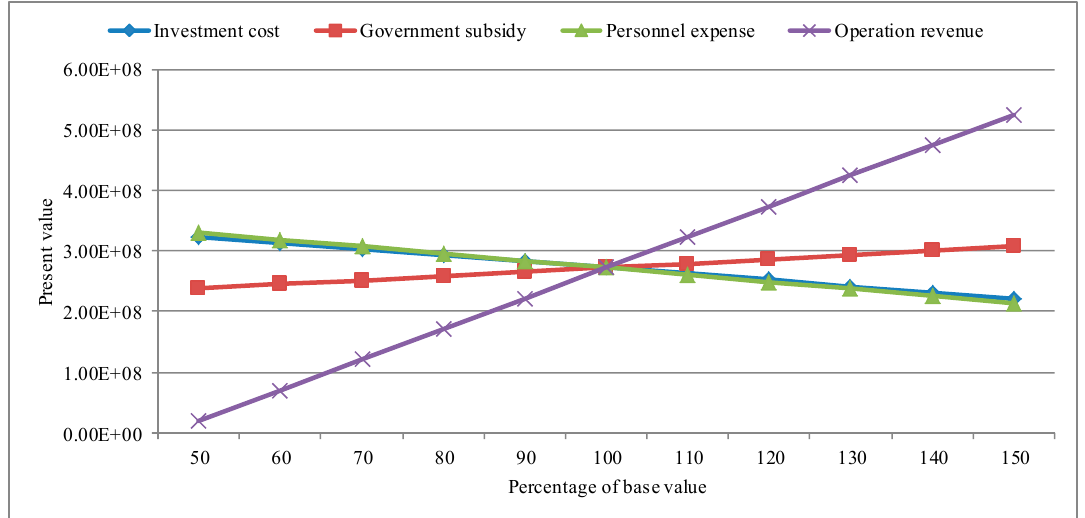
Figure 12. Sensitivity analyses of the controlled charge.